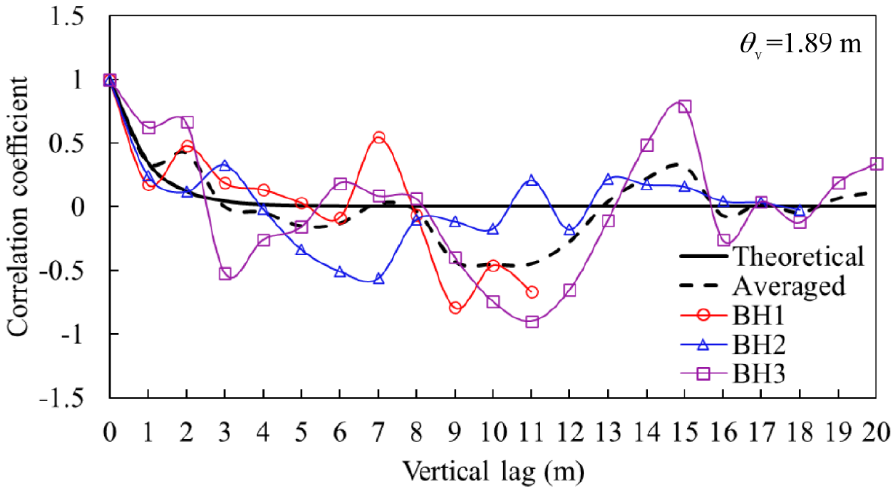
Figure 17. Vertical correlation length of the undrained shear strength.